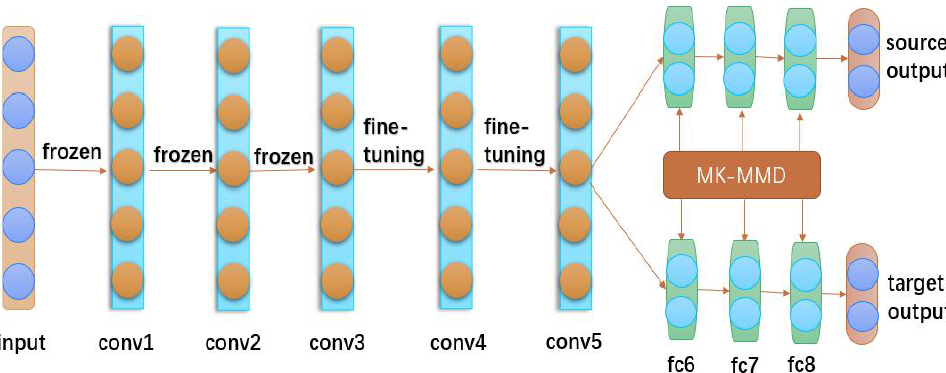
Figure 6. Structure of the DAN model with transferable features.